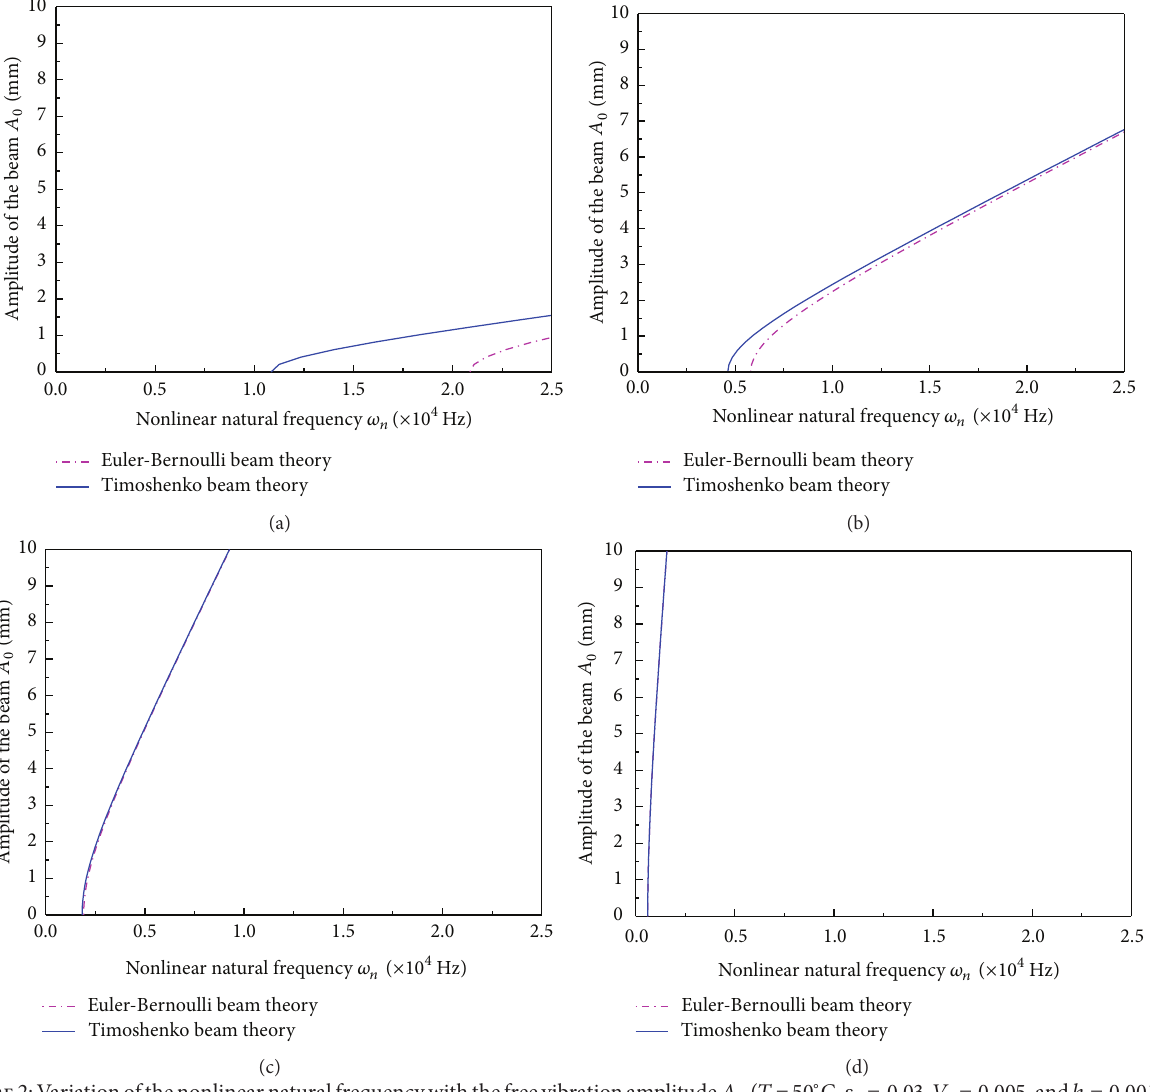
Figure2:Variationofthenonlinearnaturalfrequencywiththefreevibrationamplitude 𝐴 0 ( 𝑇 =50 ∘ C, 𝜀 0 = 0.03 , 𝑉 𝑠 = 0.005 ,and ℎ = 0.001 m): (a) 𝐿/ℎ = 5 ; (b) 𝐿/ℎ = 10 ; (c) 𝐿/ℎ = 20 ; and (d) 𝐿/ℎ = 50 . Table 3: Material properties of SMA